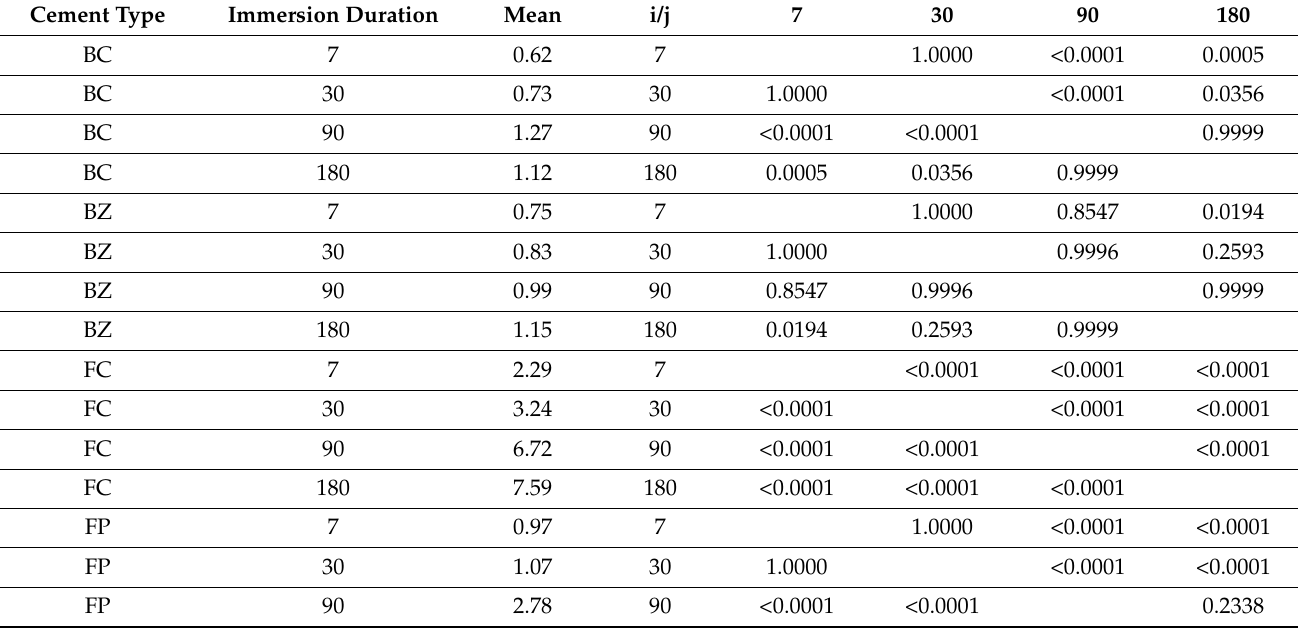
Table 8. Statistical intra group comparison (cement) of WSL (%) among different immersion sub-groups (Pair-wise comparisons within luting agent; Tukey adjusted p